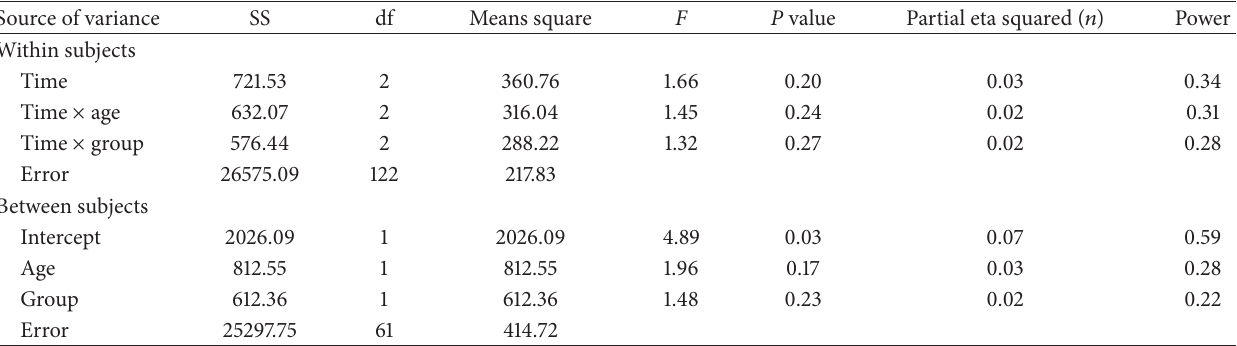
Table 2: ANCOVA results of QOLIC.